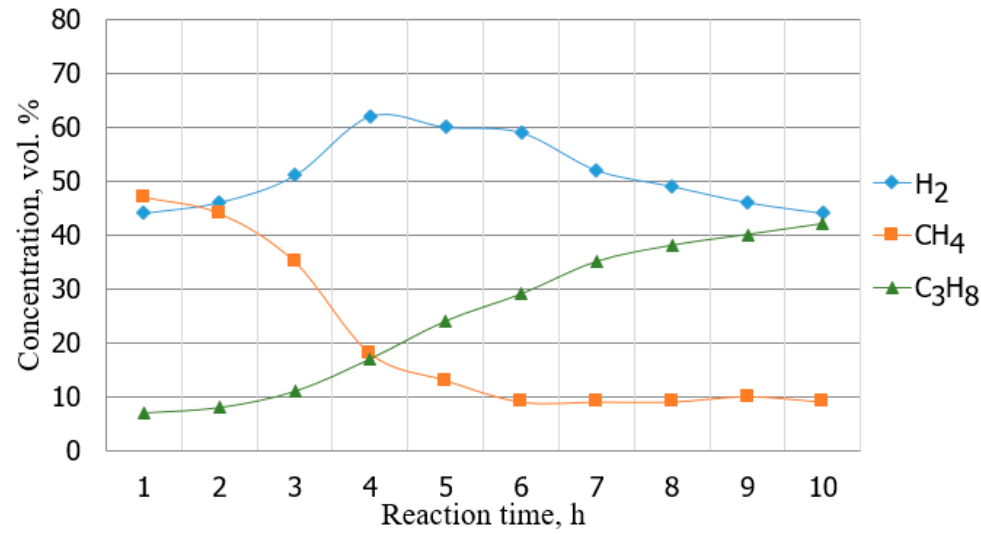
Figure 8. Reaction time dependence of the concentration of catalytic propane pyrolysis products without using a stirrer at reactor temperature 590 ± 10 °C; curves of the average concentration of propane pyrolysis products based on 150 samples are presented.